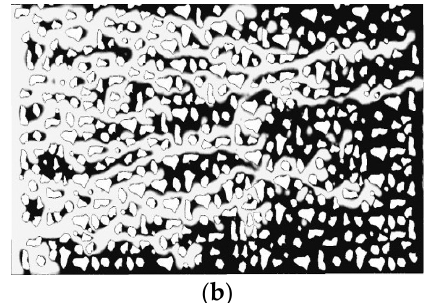
( b ) Figure 7. Flow distribution within the micromodel at rupture time. Injection velocity: 10 ft/day and IFT 2.7 mN/m. ( a ) Experimental and ( b ) simulation.